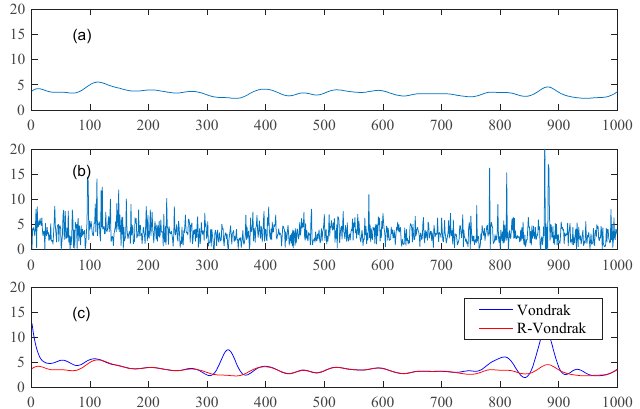
Figure 2. Comparison between the Vondrak filter and the R-Vondrak filter. ( a ) shows the original data; ( b ) shows data after adding random noise and gross errors; ( c ) shows the results of using the Vondrak (blue) and R-Vondrak Filter (red).